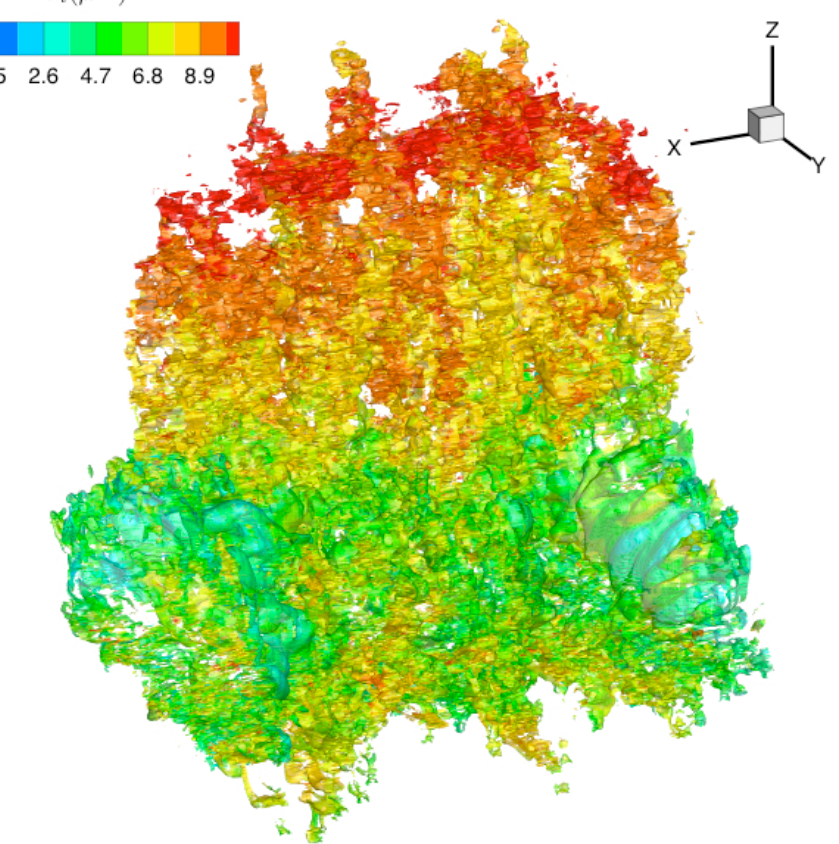
Fig. 10. Three-dimensional structure of the contrail at t = 320 s (early dissipation regime, run V D 1): iso-surface of ice density ρ i = 0 . 5 × 10 − 5 kgm − 3 colored with the radius of ice crystals.